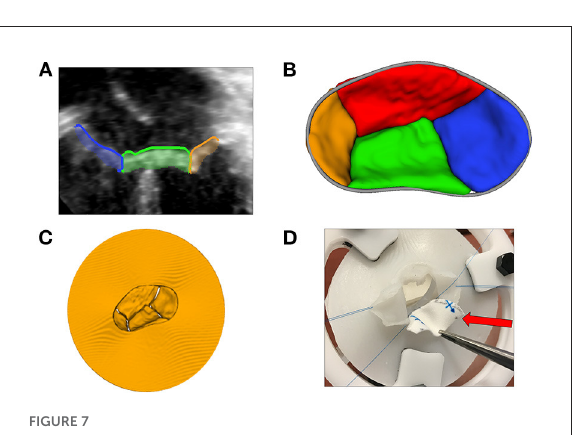
FIGURE7 3D printing and novel visualization technologies. (A) A 2D transthoracic apical view of a CAVC valve (from image left to right: right mural leaflet in blue, inferior bridging leaflet in green, and left mural leaflet in orange) segmented using the Valve Segmentation module in SlicerHeart; (B) An 3D atrial view of a segmented CAVC valve with the annular curve visible in gray; (C) A virtual model of the segmented CAVC valve with a skirt used as a template for 3D printing; (D) A surgeon practices a patch repair on a AVC valve created from a 3D echocardiogram with the dividing ventricular septal defect patch indicated by the red arrow. CAVC, complete common atrioventricular